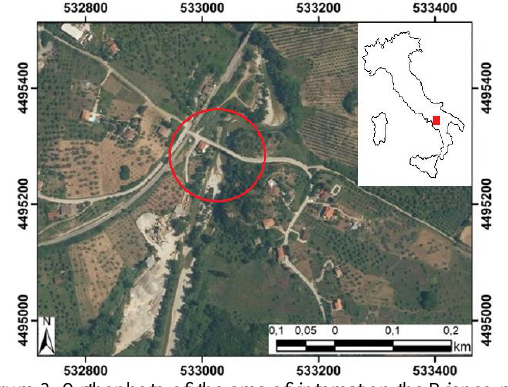
Figure 3. Orthophoto of the area of interest on the Bianco river (latitude 40 ° 36'27.84 "N; longitude 15 ° 23'25.81" E)